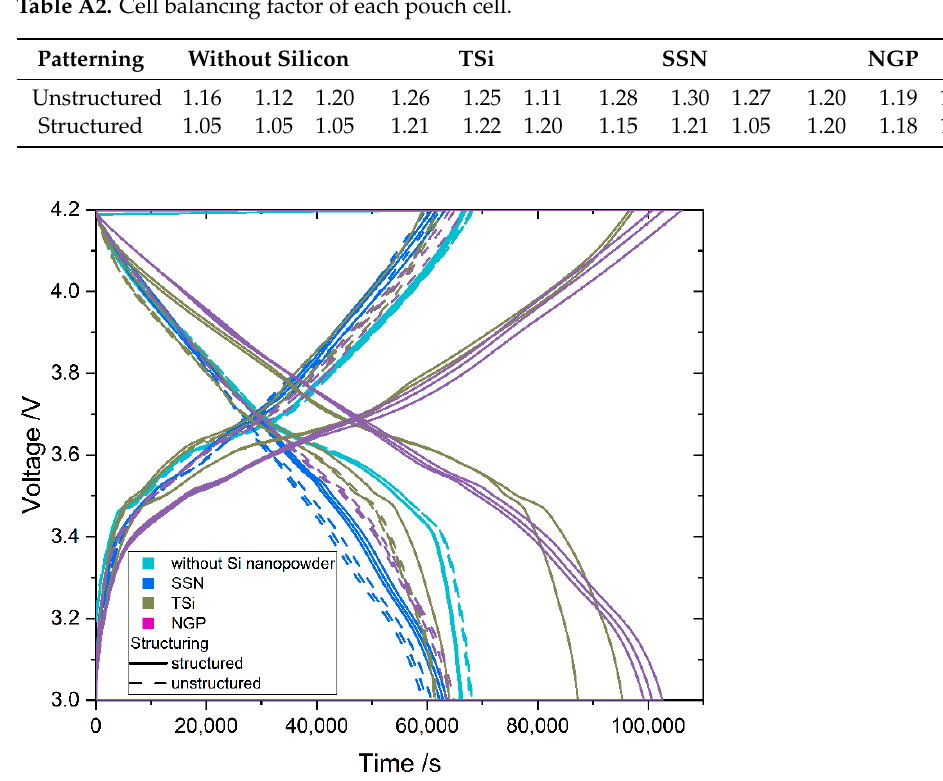
Figure A7. Voltage profiles of the pouch cells during formation at C/20.